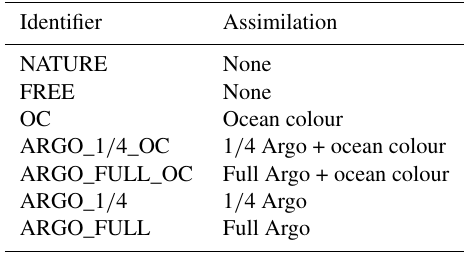
Table 1. Experiments